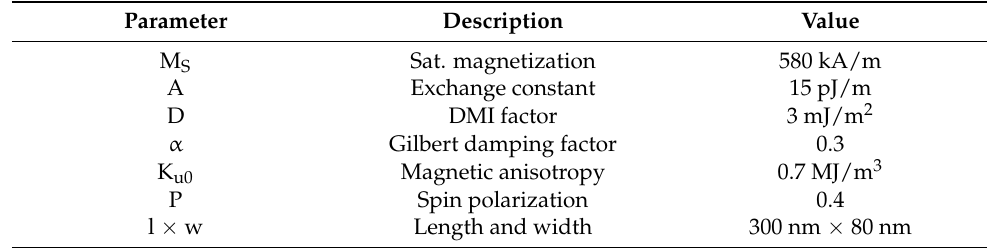
Table 1. Key parameters in